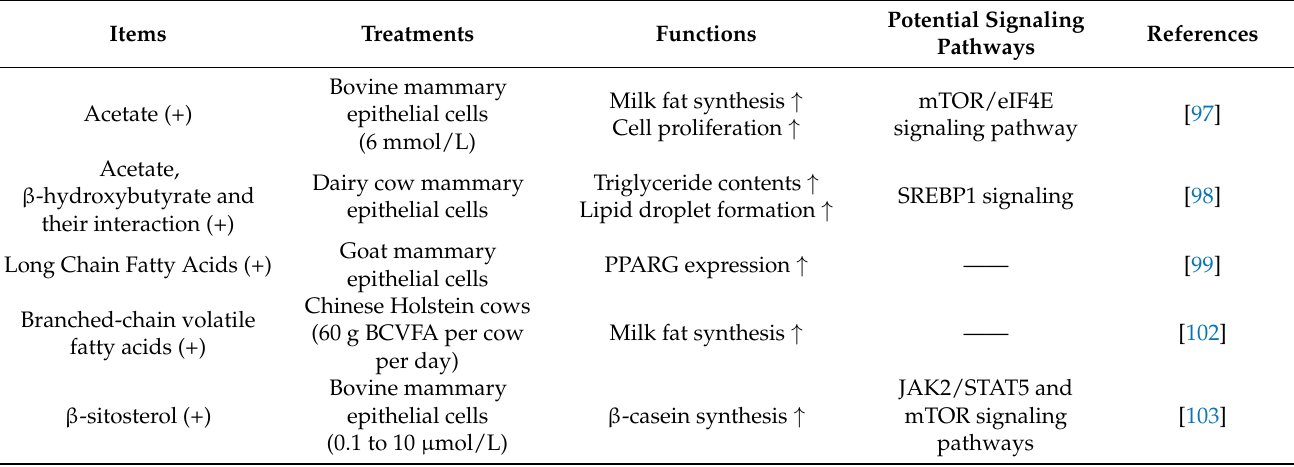
Table 3. Effects of fatty acids on milk production and its potential regulatory